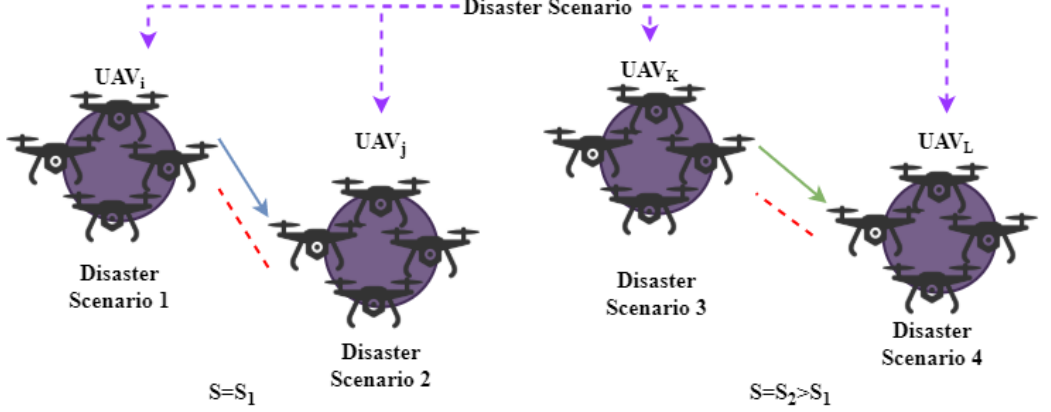
Figure 1. Disaster Monitoring Scenario based on UAV.